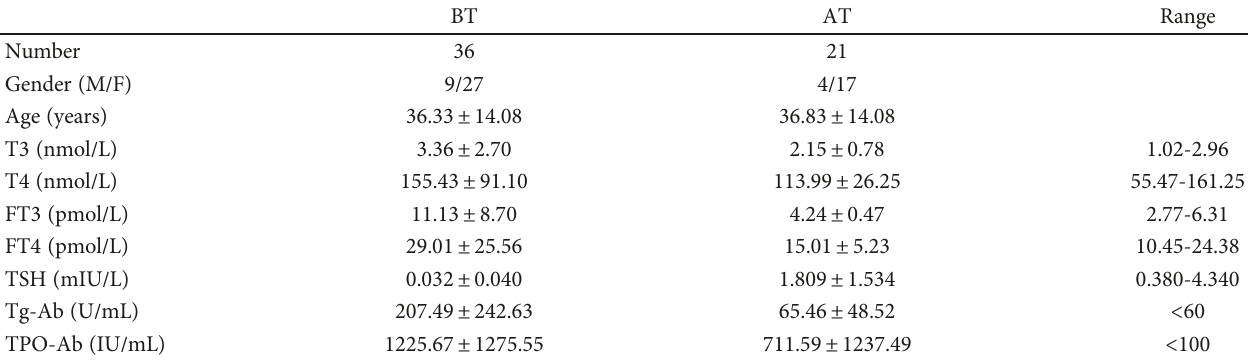
Table 1: Main characteristics of patients with GD included in this study. BT